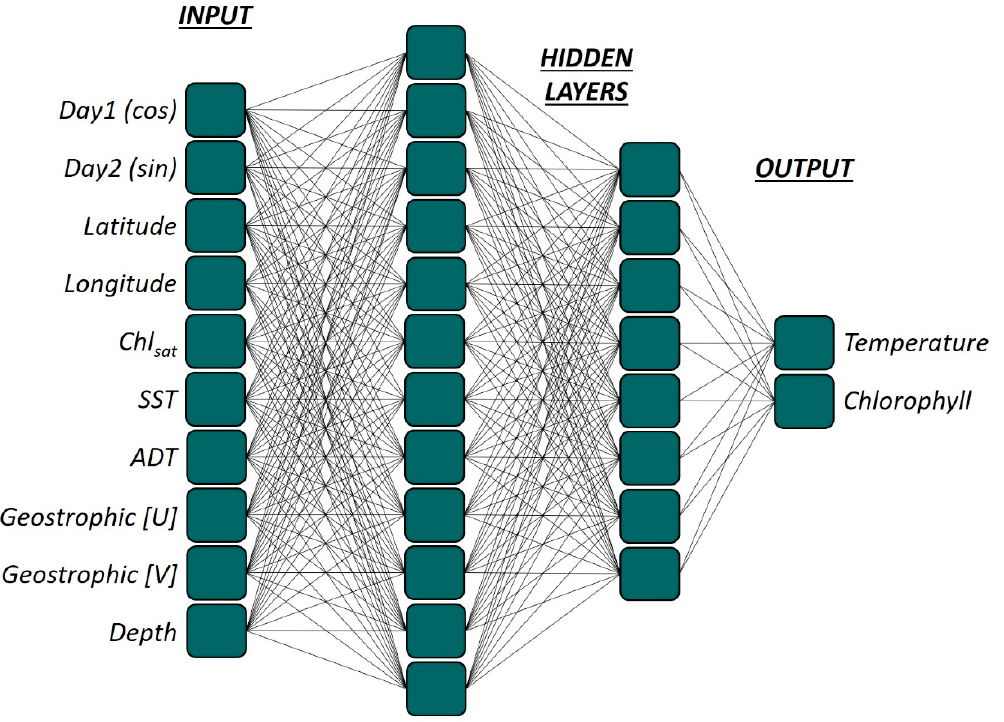
Figure 2. Multi-Layer-Perceptron architecture with two hidden layers and two outputs (10-12-8-2).